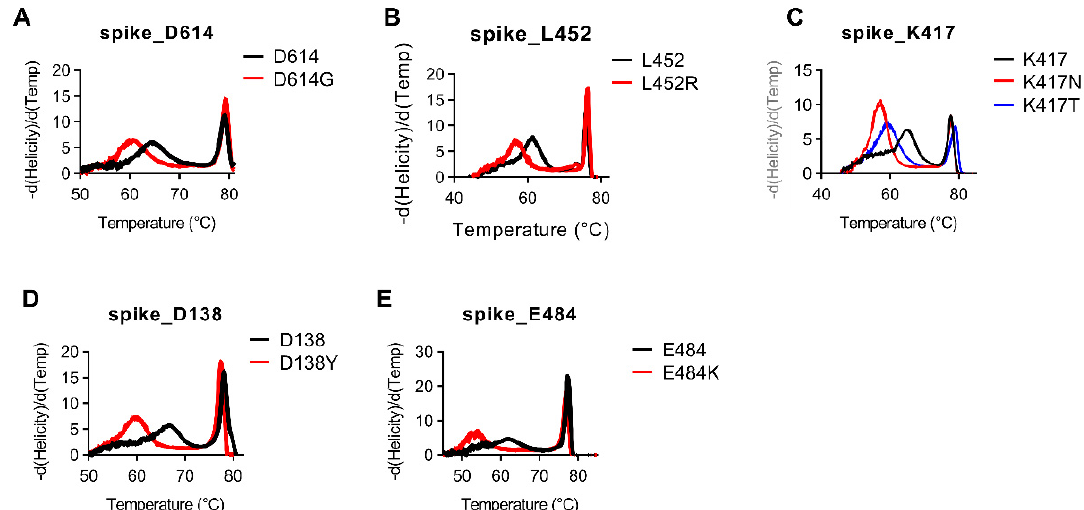
Figure 4. Snapback HRM clearly distinguishes SARS-CoV-2 SNVs. ( A ) High-resolution melting plots for the spike_D614 assay with D614 in black and D614G in red. ( B ) High-resolution melting plots for the spike_L452 assay with L452 black and L452R in red. ( C ) High-resolution melting plots for the spike_K417 assay with K417 in black, K417N in red, and K417T in blue. ( D ) High-resolution melting plots for the spike_D138 assay with D138 in black and D138Y in red. ( E ) High-resolution melting plots for the spike_E484 assay with E484 black and E484K in red.